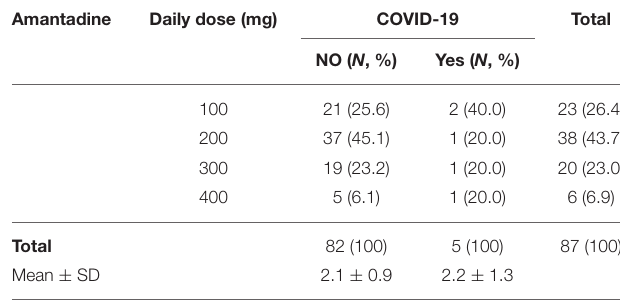
TABLE 1 | Socio-demographic characteristics of both groups. TABLE 2 | Amantadine doses in group I.